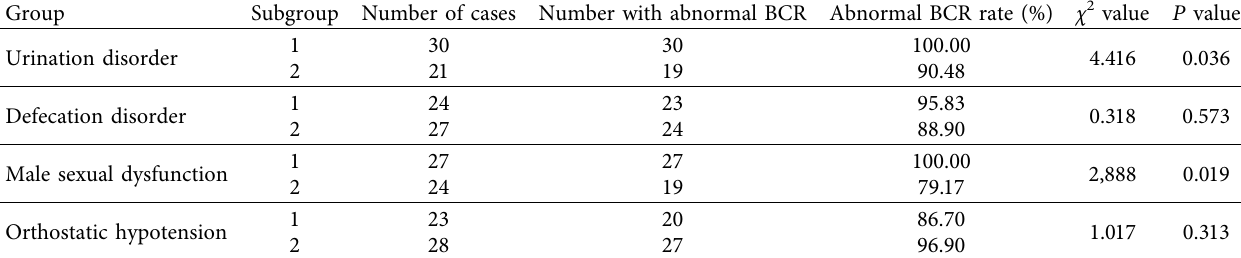
Table 6: Comparison of rates of BCR abnormalities in MSA patients with abnormal sacral spinal cord function and without abnormal sacral spinal cord function.